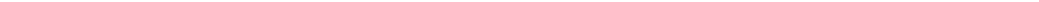
(see fi gure on previous page) Fig. 6 Double inhibition of EZH2 and SQLE decreases HNSCC tumour growth in vivo. A Relative tumour (CAL27 cells) volume showed that EZH2 and SQLE inhibitors signi fi cantly inhibited tumour growth. N = 6 replicates, two-way ANOVA analysis was used to assess the statistical signi fi cance, *** p < 0.001, **** p < 0.0001. B Representative image of the tumour (CAL27 cells). C Relative tumour (HN6 cells) volume showed that EZH2 and SQLE inhibitors signi fi cantly inhibited tumour growth. N = 6 replicates, *** p < 0.001, **** p < 0.0001. D Representative image of the tumour (HN6 cells). E Detection of cholesterol metabolizing enzyme-related genes in tumour tissues by real-time PCR. N = 3 replicates, one-way ANOVA analysis was used to assess the statistical signi fi cance, * p < 0.05, ** p < 0.01, *** p < 0.001, **** p < 0.0001 vs vehicle. F Quantitative concentrations of squalene in vehicle or ET combination-treated CAL27 tumours. N = 3 replicates, two-way ANOVA analysis was used to assess the statistical signi fi cance, **** p < 0.0001. G Relative tumour volume showed that combination of EZH2 and SQLE inhibitors failed to inhibit tumour growth of sh- FDFT1-treated CAL27 xenograft compared to the sh-NC group. H The expression levels of SQLE, H3K27me3 and Ki67 in tumour tissues of different treatment groups were detected by immuno fl uorescence staining.